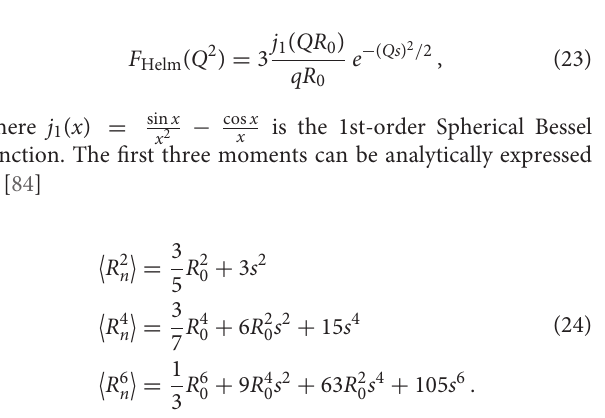
Frontiers in Physics |